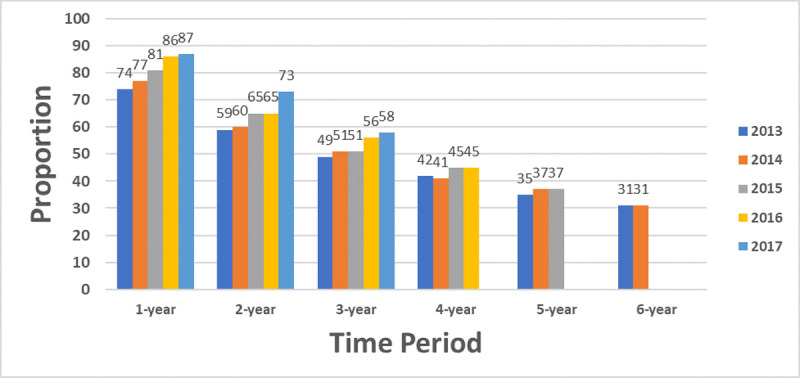
Viral suppression and durable viral suppression by time period, 2013–2017.